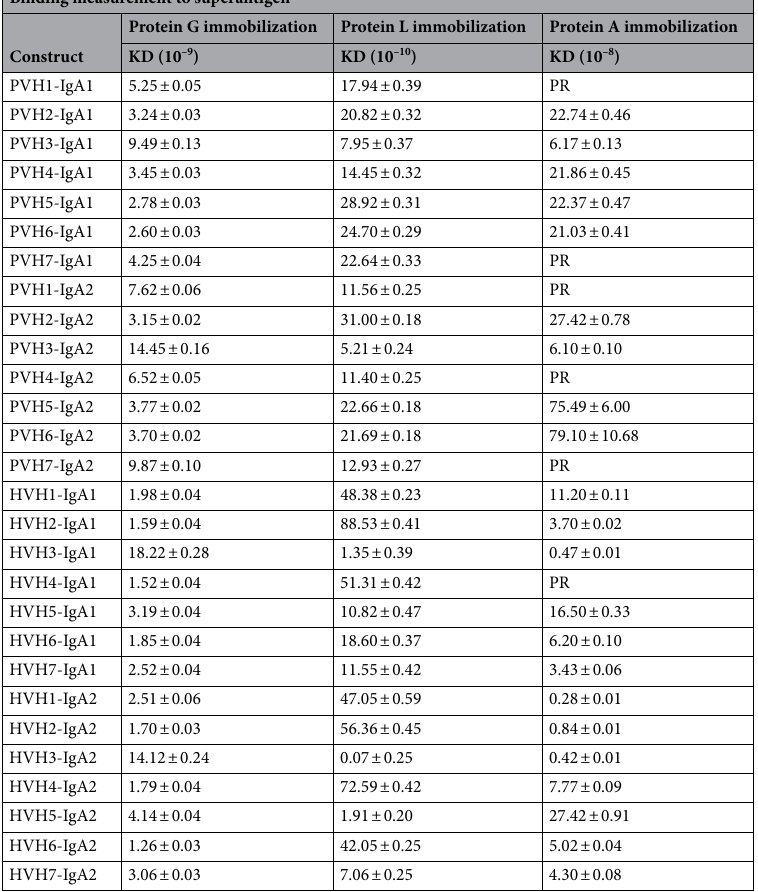
Table 3. BLI measurements of immobilized proteins G, L and A interacting with Pertuzumab (PVH) and Trastuzumab (HVH) 1–7 IgA1 and IgA2. The KD values with standard error of each variant are shown accordingly. Poor response (PR) indicates that the antibody construct did not yield reliable ka and kd measurements (in triplicates). All measurements were performed in triplicates and rounded off to the nearest 2 decimal place. The ka and kd values are shown in Supplementary Table